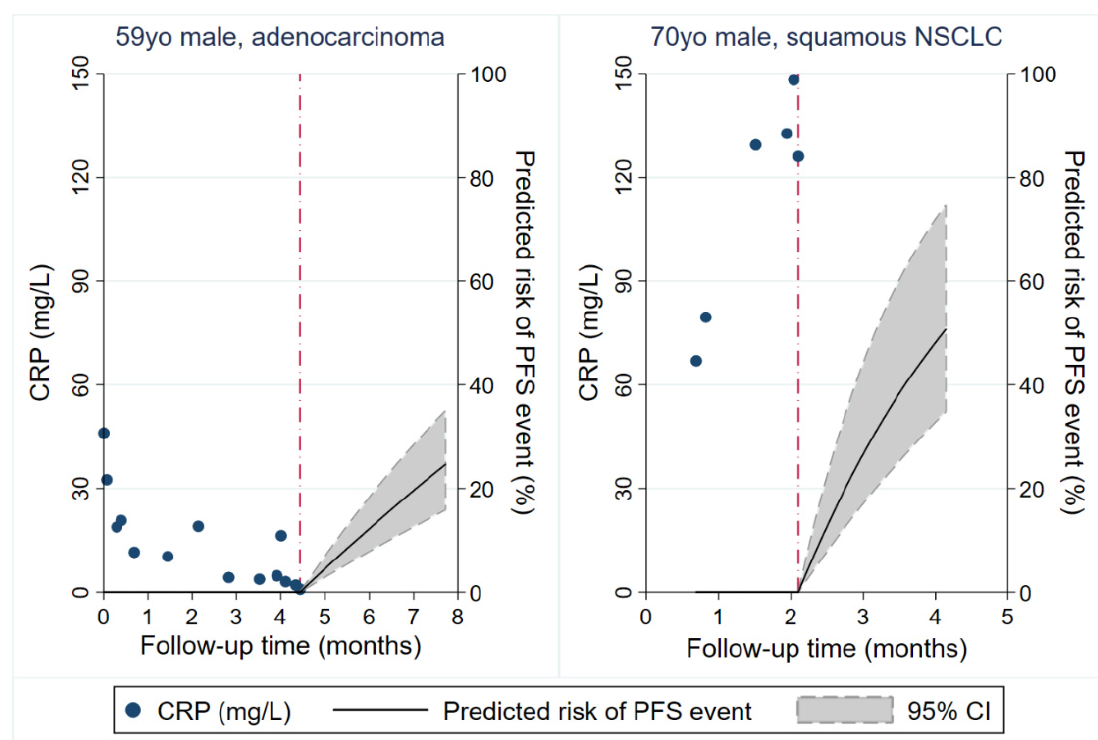
Figure 5. Personalized prediction of ICI therapy PFS outcomes based on individual patients longitudinal